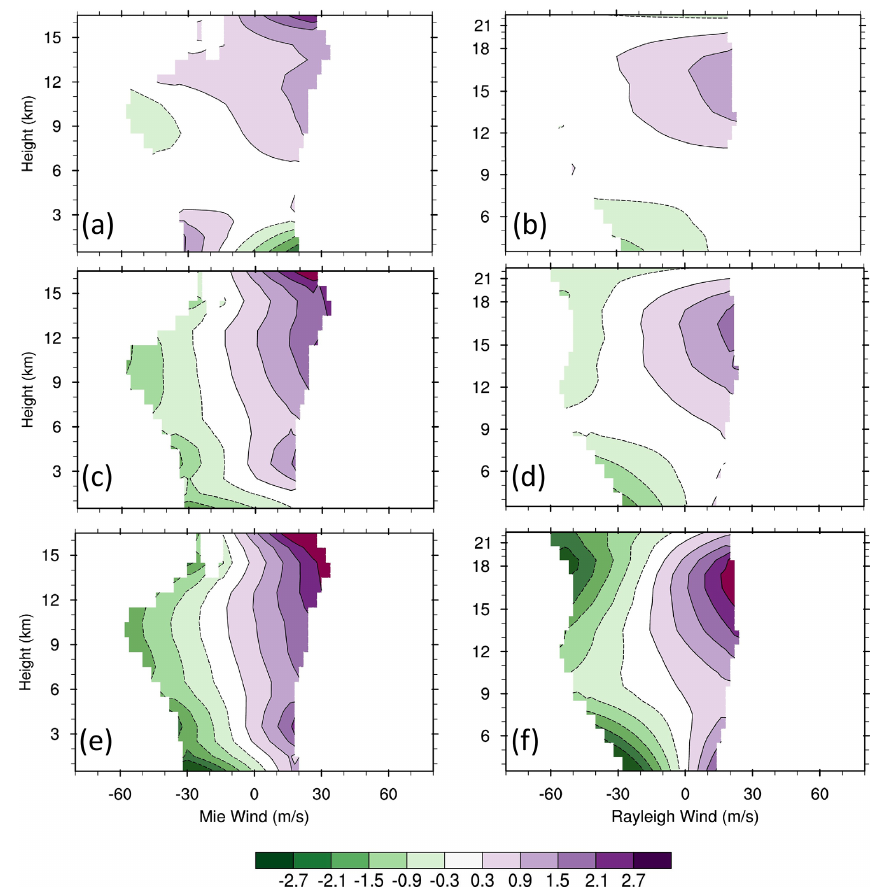
Figure 12. Vertical distributions of average bias estimates (color scale; ms − 1 ) for Mie (a, c, e) and Rayleigh (b, d, f) winds as a func- tion of Aeolus winds using one of three methods for descending orbits for all latitudes. The methods are OLS using FV3GFS winds as a predictor (a, b) , TLS ( c, d ; same as the bottom panels of Fig. 8), and OLS using the average of Aeolus and FV3GFS as a predictor (e, f)